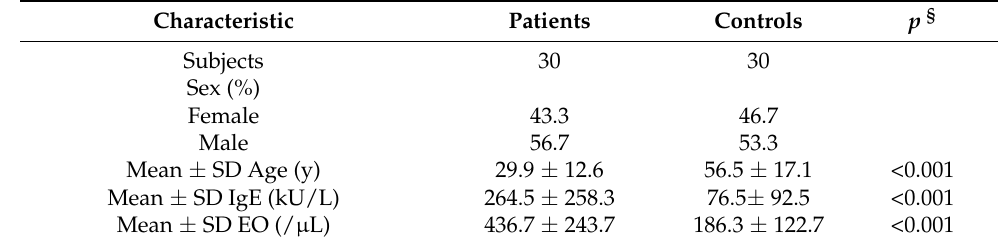
Table 1. Phenotypic characteristics of the population of the transcriptomic assay.